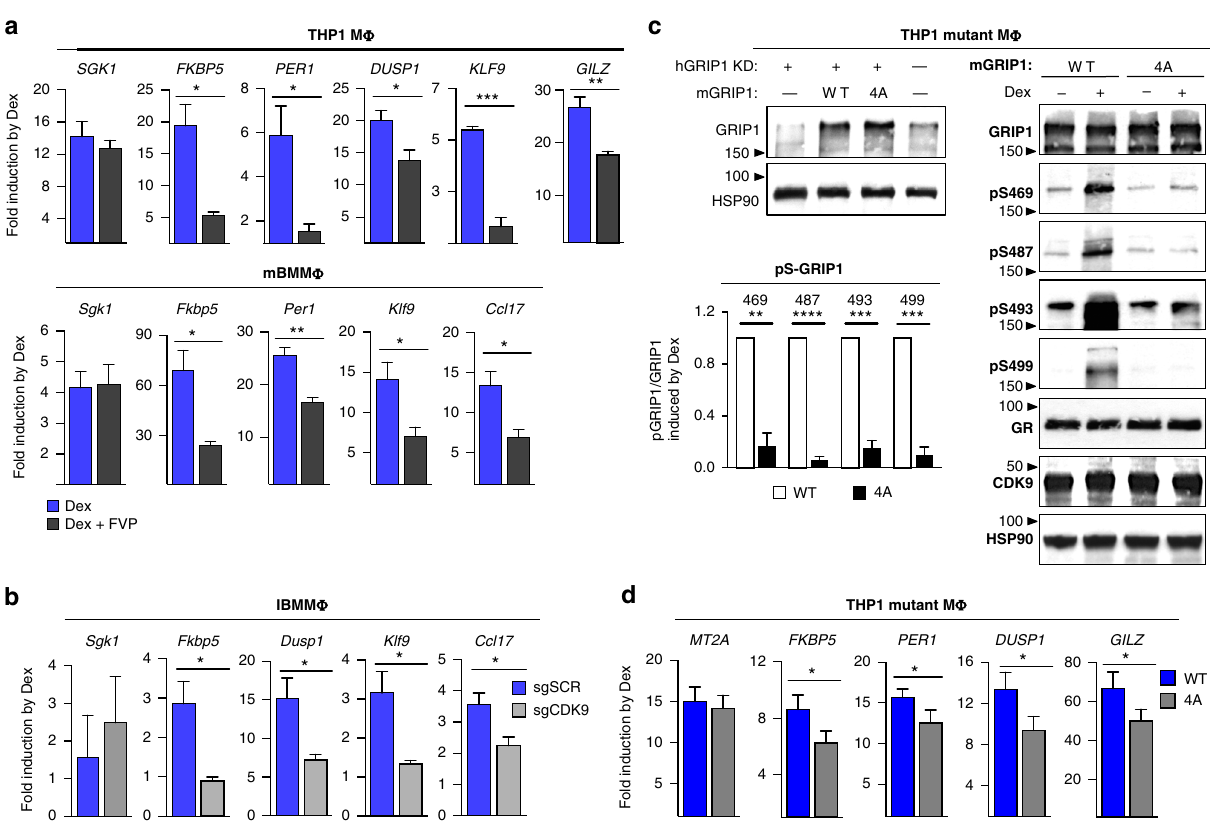
Fig. 3 GRIP1 phosphorylation potentiates GR-mediated transcriptional activation. a THP1 cells or BMM Φ were treated ± dexamentasone (Dex) ± 50 nM fl avopiridol (FVP) for 2 h and “ fold induction ” of indicated genes analyzed by RT-qPCR, normalized to β -actin and expressed relative to untreated or FVP alone ( = 1); mean+SEM are shown; n ≥ 3. b The induction by Dex (30 min) of GR target genes in single guide (sg)CDK9 and scrambled sgSCR control IBMM Φ was analyzed by RT-qPCR as in a ; mean + SD is shown, n = 4. c THP1 cells transduced with SCR shRNA (-) or those depleted of endogenous hGRIP1 (+) from Fig. 1a, were stably transduced with WT or 4A mGRIP1 (see “ Methods ” ), as indicated, and GRIP1 expression tested by immunoblotting with HSP90 is a loading control (left). WT- and S469A/S487A/S493A/S499A (4A)-expressing THP1 cells were treated ± Dex for 2 h and GRIP1 (total and phospho-isoforms), GR, CDK9 and HSP90 were visualized by immunoblotting (right). Quanti fi cation was performed as in Fig. 2c and expressed relative to WT ( = 1); mean + SEM are shown; n ≥ 3. Full-size western blots are shown in Supplementary Fig. 10g. d WT and 4A THP1 cells were treated ± Dex for 2 h and the expression of GR target genes was analyzed by RT-qPCR as in a ; mean + SEM are shown, n ≥ 3. In each panel * P < 0.05, ** P < 0.01, *** P <